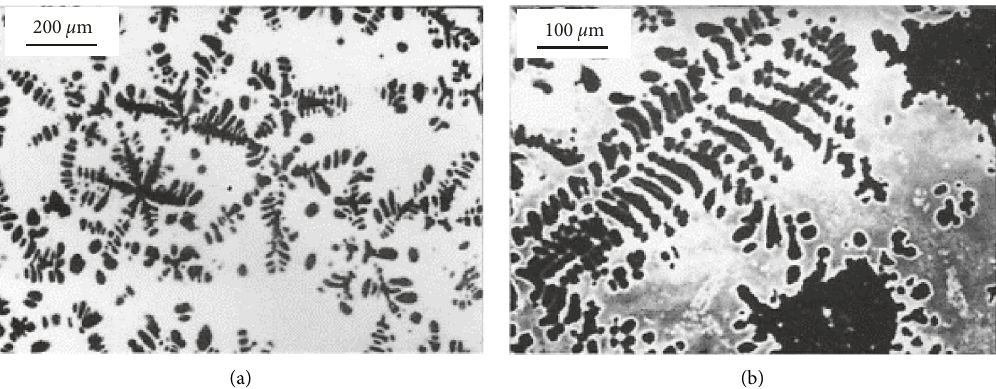
Figure 13: SEM photos of CuCr25 alloy: (a) normal microstructure and (b) coarse Cr dendrite and Cr microsegregation [30].